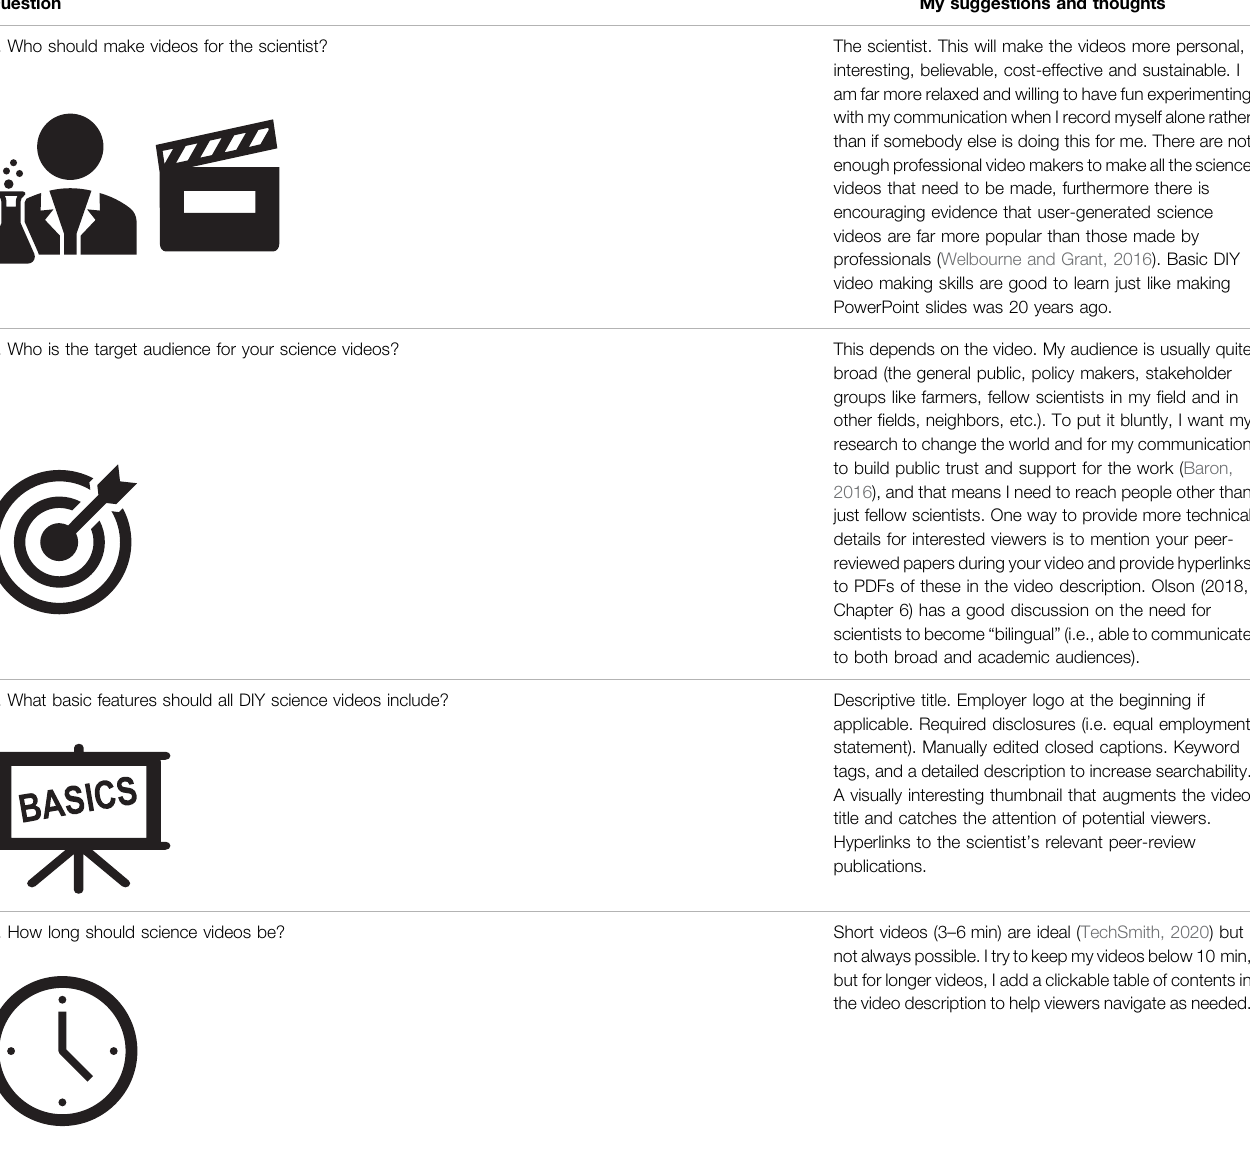
TABLE1| ImportantquestionstoconsiderwhenproducingDo-It-Yourself(DIY)sciencevideos,andorganizingandmanagingthemonYouTube(YT).Pleaseemailmeifyou have other questions that I have not